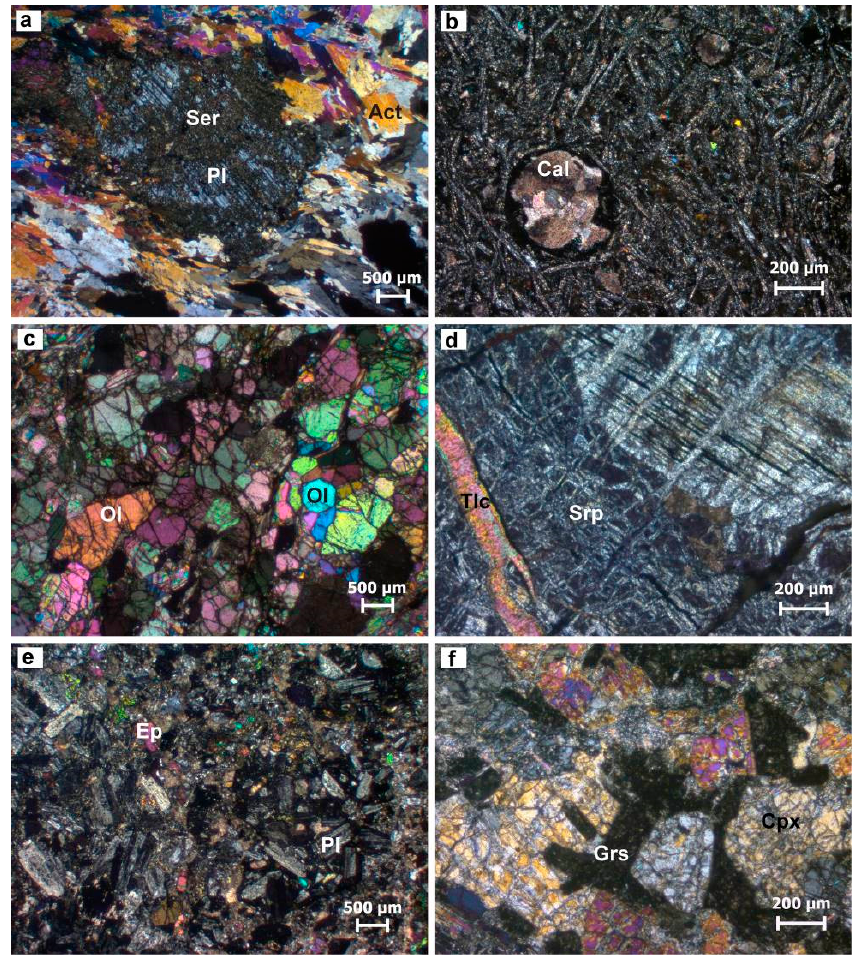
Figure 3. Photomicrographs (XPL) of: ( a ) sericitized plagioclase porphyroblast surrounded by slender prisms of actinolite (NA9 amphibolite, Naxos); ( b ) intersertal texture with amygdule filled with secondary calcite and iron oxides (NA3 spilite, Naxos); ( c ) equigranular polygonal olivine crystals forming a mosaic texture in dunite (NA6 dunite, Naxos); ( d ) mesh texture and bastite pseudomorph in serpentinite (PA12 serpentinite, Paros); ( e ) porphyritic intersertal texture in meta-andesite (SA8 meta-andesite, Samos); ( f ) blasto-subophitic texture in rodingite (SK1 rodingite, Skyros). (Act: Actinolite, Cal: Calcite, Cpx: Clinopyroxene, Ep: Epidote, Grs: Grossular, Ol: Olivine, Pl: Plagioclase, Ser: